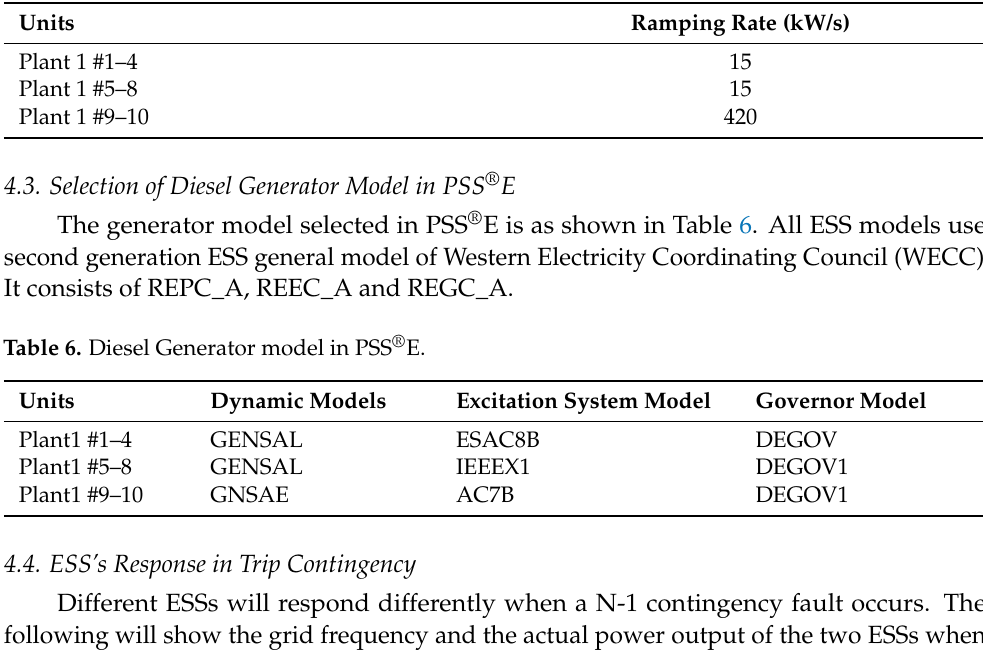
Table 5. The ramping rate of the generator set.